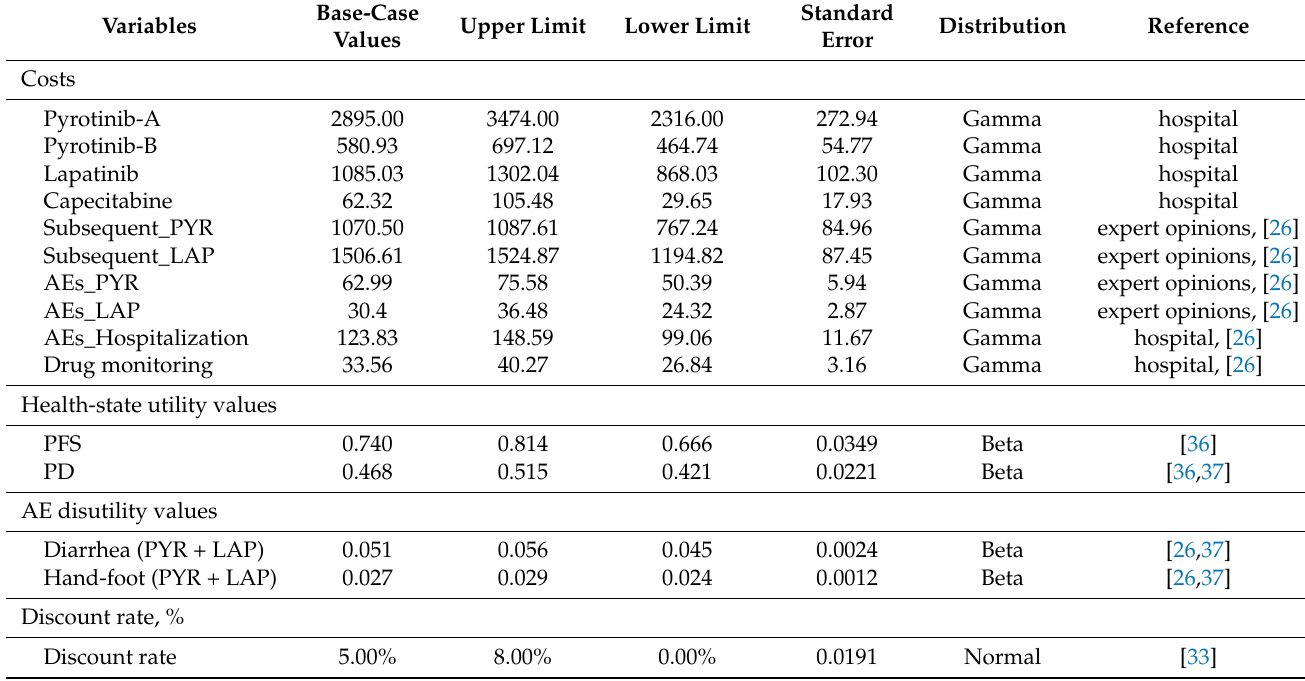
Table 1. Summary of base-case values in